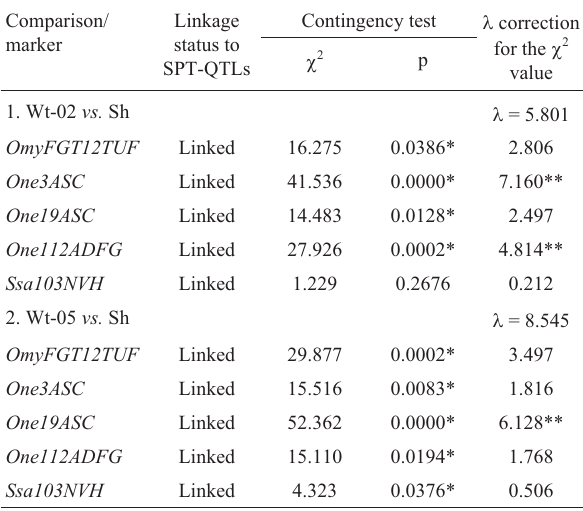
Table 3 - Correction for stratification in the association analysis between spawning time QTL markers and the double annual reproductive cycle trait in rainbow